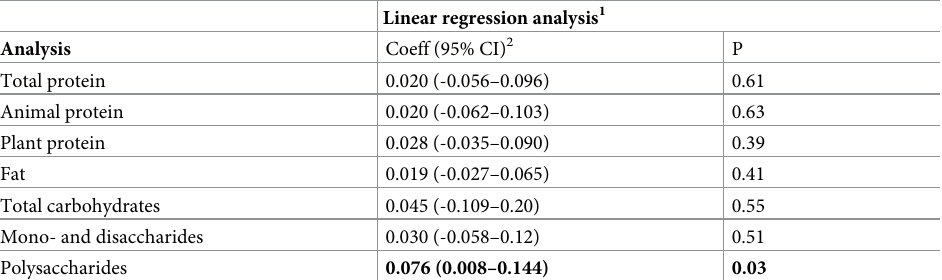
Table 2. Linear regression analysis of macronutrient intake in relation to birth weight (n = 1698,